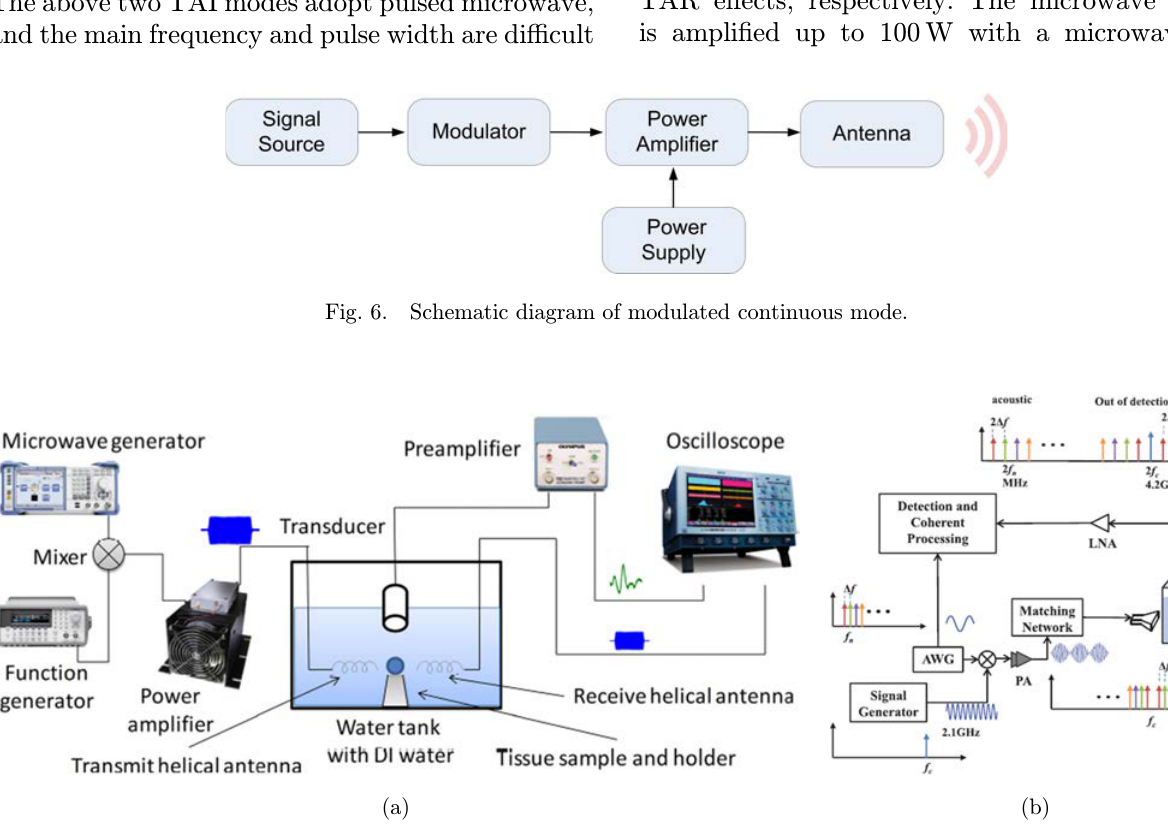
Fig. 7. (a) Schematic diagram of the experimental setup for the observation of both TA and TAR e®ect induced by single-pulse and multi-pulse microwave source. (b) The schematic of the experiment setup. The AWG sends out the stepped-frequency envelope signal that modulates the microwave carrier.